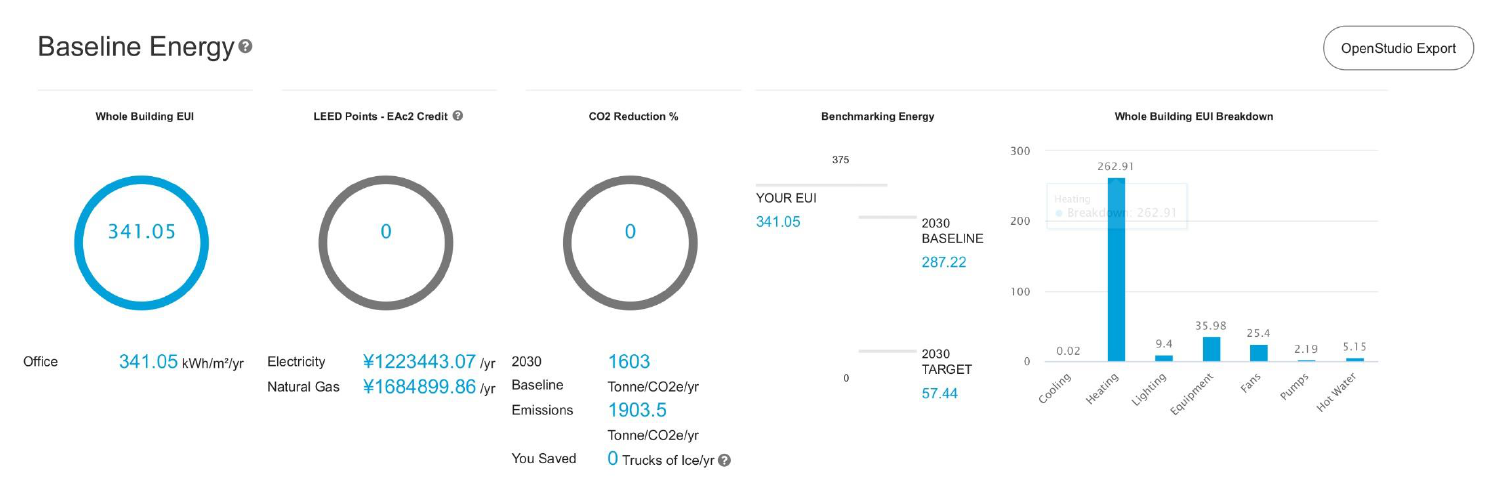
Figure A29. Zone 5-H Lhasa, Xizang (post-COVID-19 78% scenario).